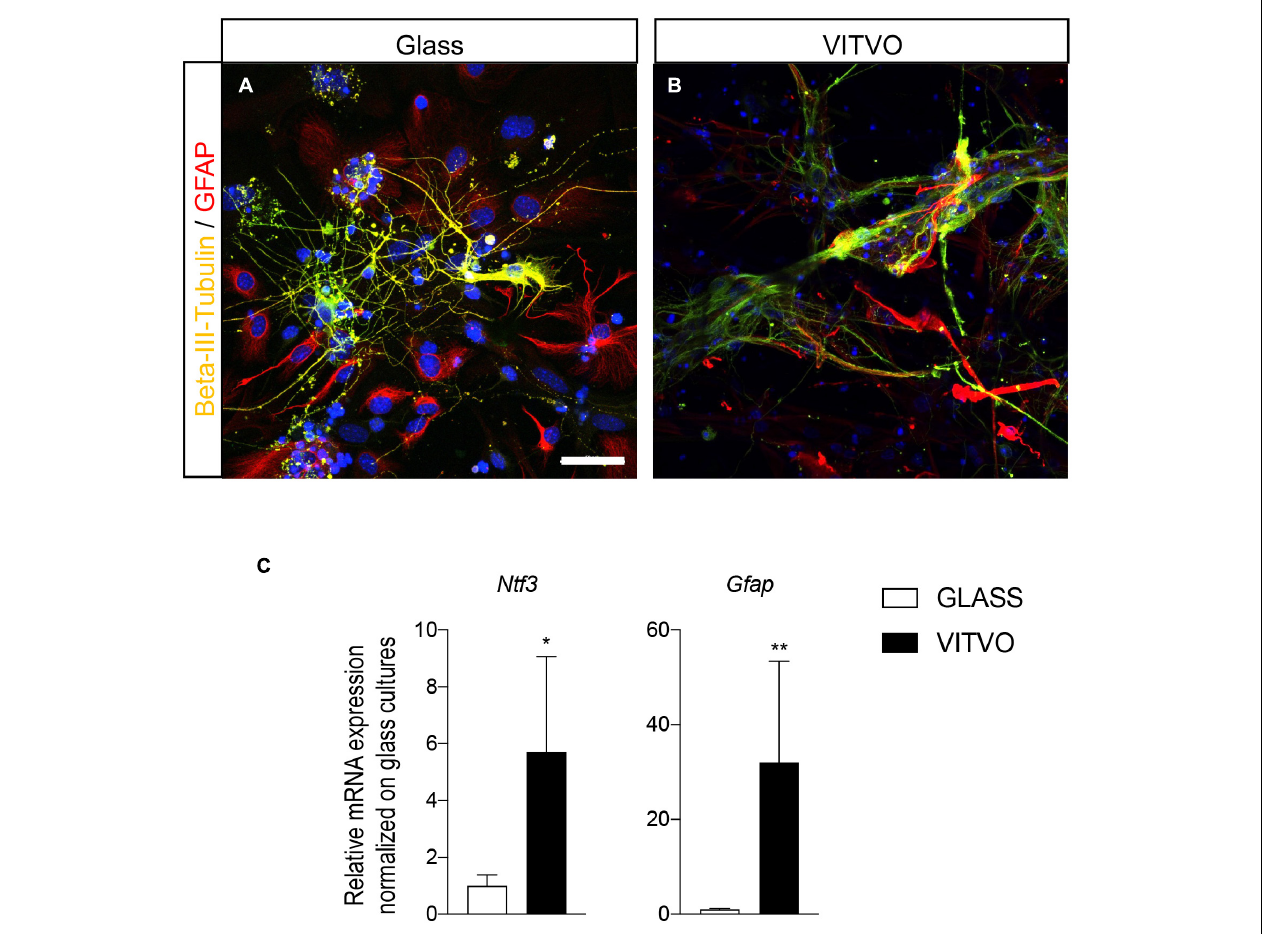
FIGURE 3 | (A,B) Representative images of neurons and astrocytes seeded on laminin coated glass (A) or in VITVO device (B) after 10 days in culture. Scale bar: 50 µ m. (C) Graphs represent expression of Ntf3 and Gfap genes in neural stem cells seeded on glass or laminin after 10 days in culture. Statistical analysis: Student’s t -test. Asterisks represent differences between cultures seeded on glass or in VITVO (* p < 0.05; ** p <